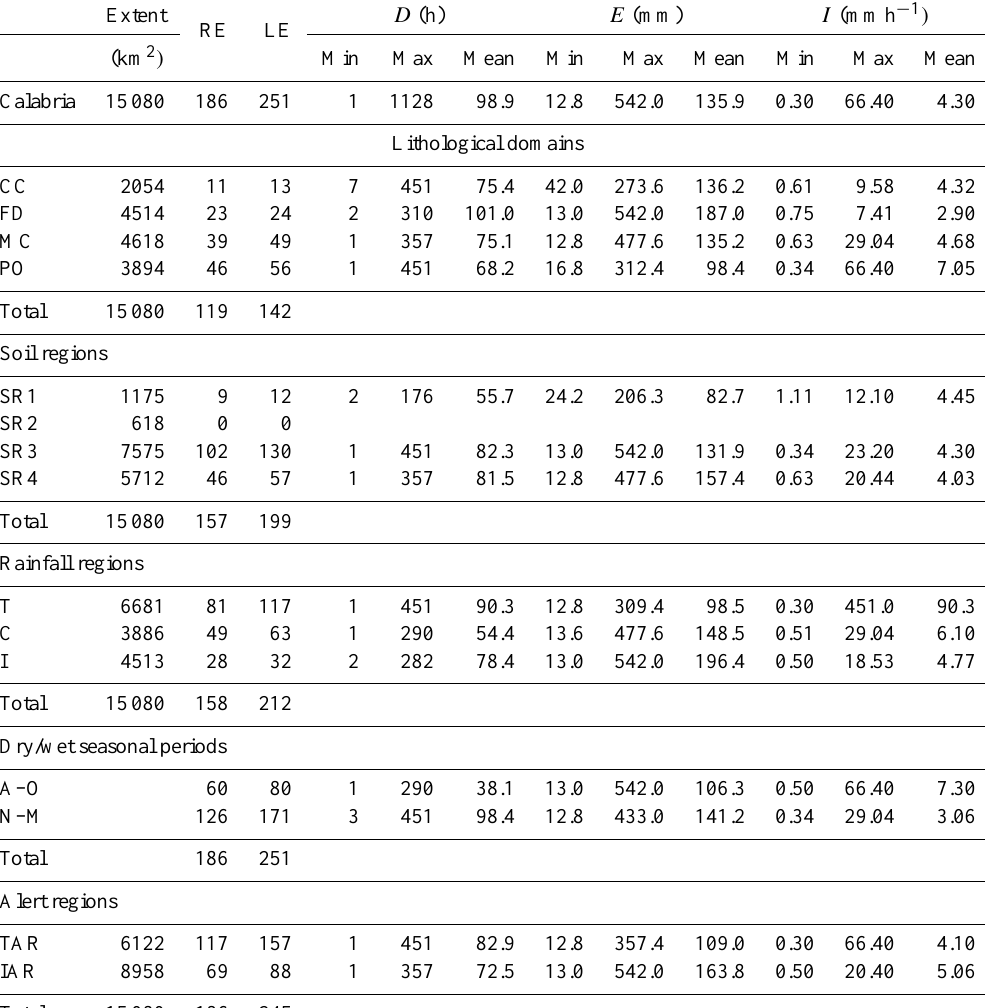
Table 3. Descriptive statistics for landslides and for the corresponding rainfall events in Calabria in the period January 1996–September 2011. Rows: RE, number of rainfall events; LE, number of landslide events; D , rainfall duration (hours); E , cumulated event rainfall (mm); I , rainfall mean intensity (mmh − 1 ) . Columns: CC, carbonate rocks; FD, flysch deposits; MC, metamorphic and crystalline rocks; PO, post- orogenic sediments; SR1, Pollino range and the neighbouring hills; SR2, northern Ionian coastal zone; SR3, coastal hills and plains; SR4, Sila, Serre and Aspromonte ranges; T, Tyrrhenian rainfall region; C, Central rainfall region; I, Ionian rainfall region; TAR, Tyrrhenian